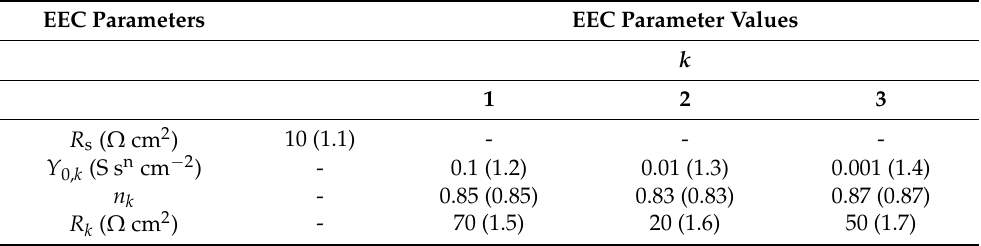
Table 3. The starting values of the EEC R(QR)(QR)(QR) parameters used to initiate the fits in this work. The values in parentheses represent poor starting values taken by design to be far from the optimal values.